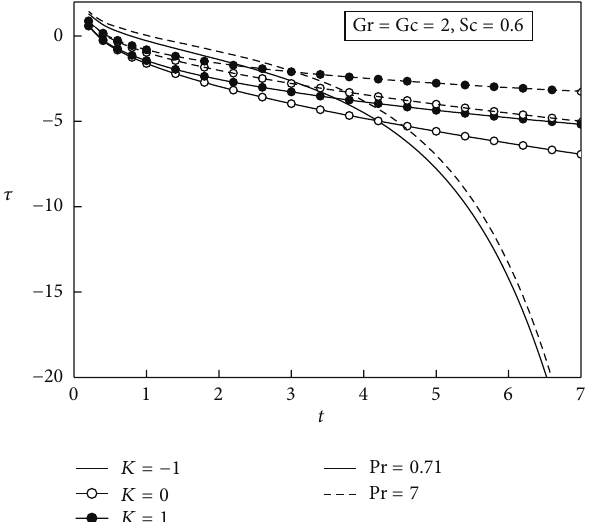
Figure 9: Effects of 𝐾 and Pr on skin friction at Gr = 2, Gc = 2, and Sc =